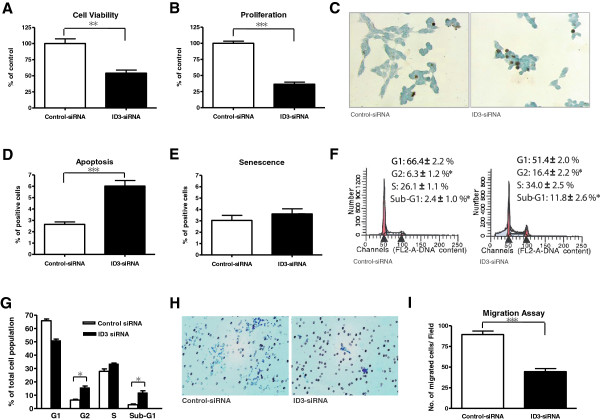
In vito cellular effects of ID3 knockdown by siRNA in D283 cells. (A) Cellular viability was assessed using CCK assays. There was a significant reduction of cell viability (B) Cell proliferation was significantly decreased, assessed using BrdU assays. (C) Apoptosis was assessed using TUNEL staining (40×). (D) Quantification of TUNEL-positive cells revealed a significant increase of apoptosis after siRNA treatment. (E) There was no difference in senescence, assessed using β-gal staining. (F and G) Cell cycle analysis using FACS showed that G2 phase and sub-G1 fractions were increased after siRNA treatment. Migratory ability was assessed using transwell migration assays. (H) Representative field images (100×) and (I) the quantification of migrated cells revealed suppression of cell migration by ID3-siRNA. Error bars represent standard deviations.